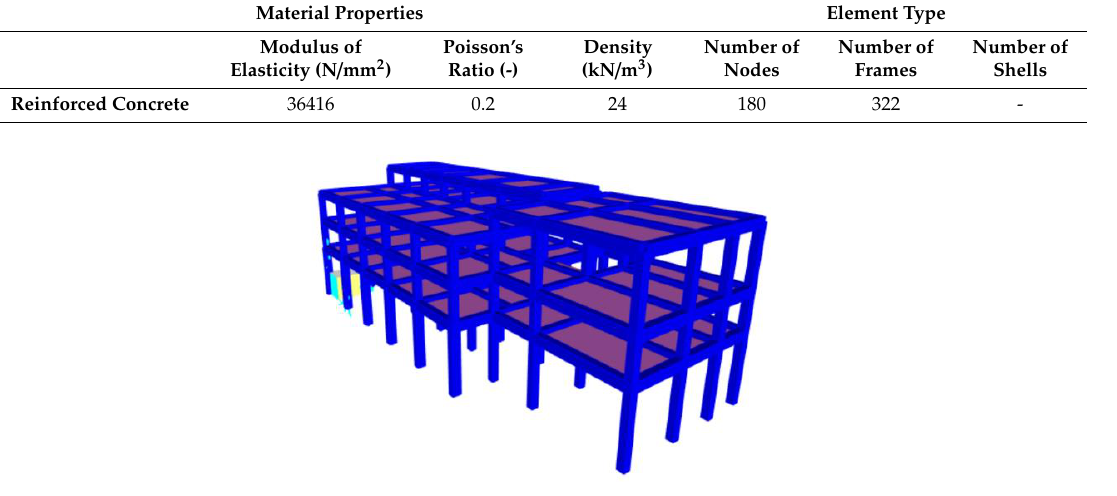
Figure 20. 3D Finite Element Model of Structure B.